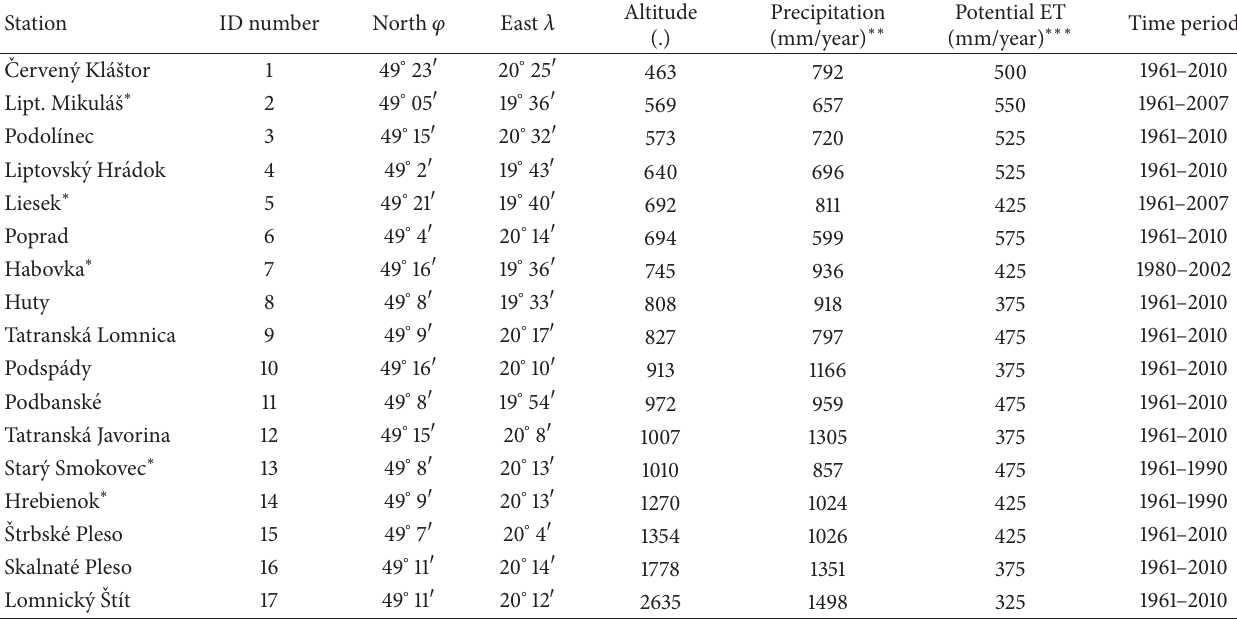
Table 1: Meteorological stations used in this study with their selected parameters.